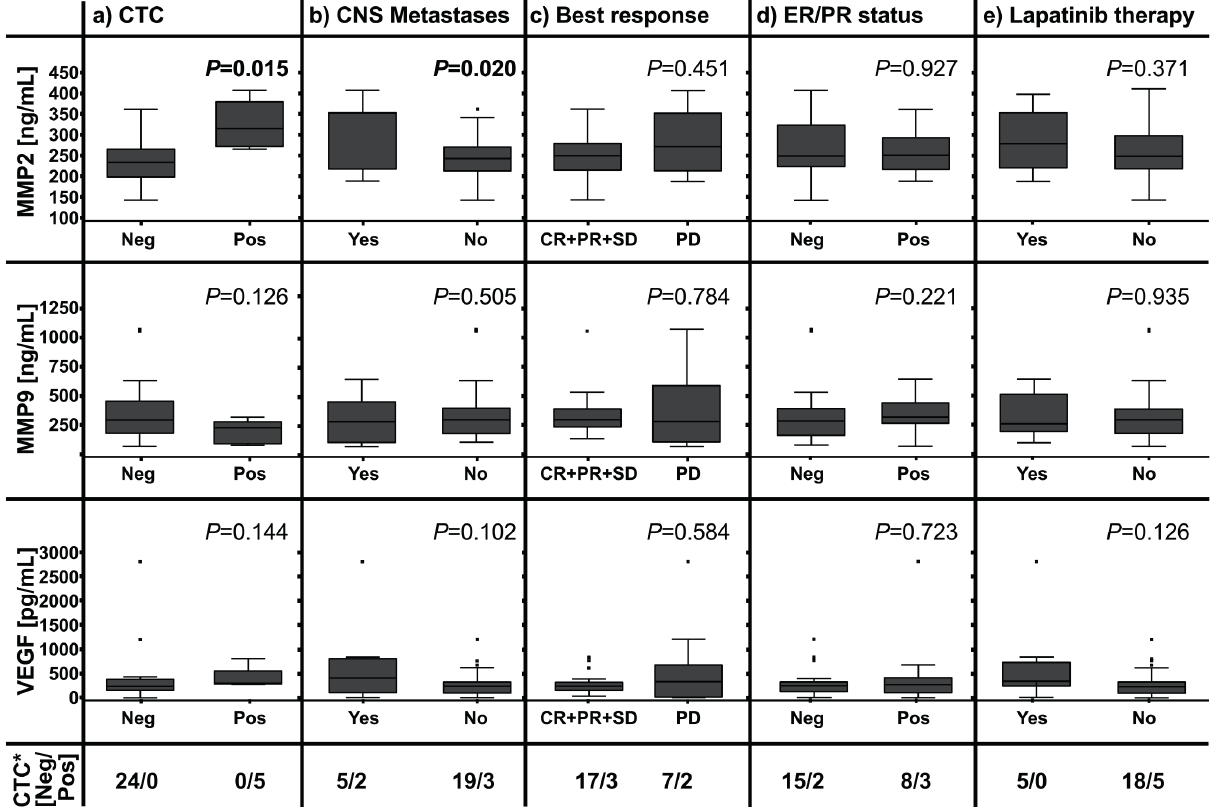
Fig. 1. The comparison of MMP-2, MMP-9 and VEGF serum levels and CTC presence in HER2 BC